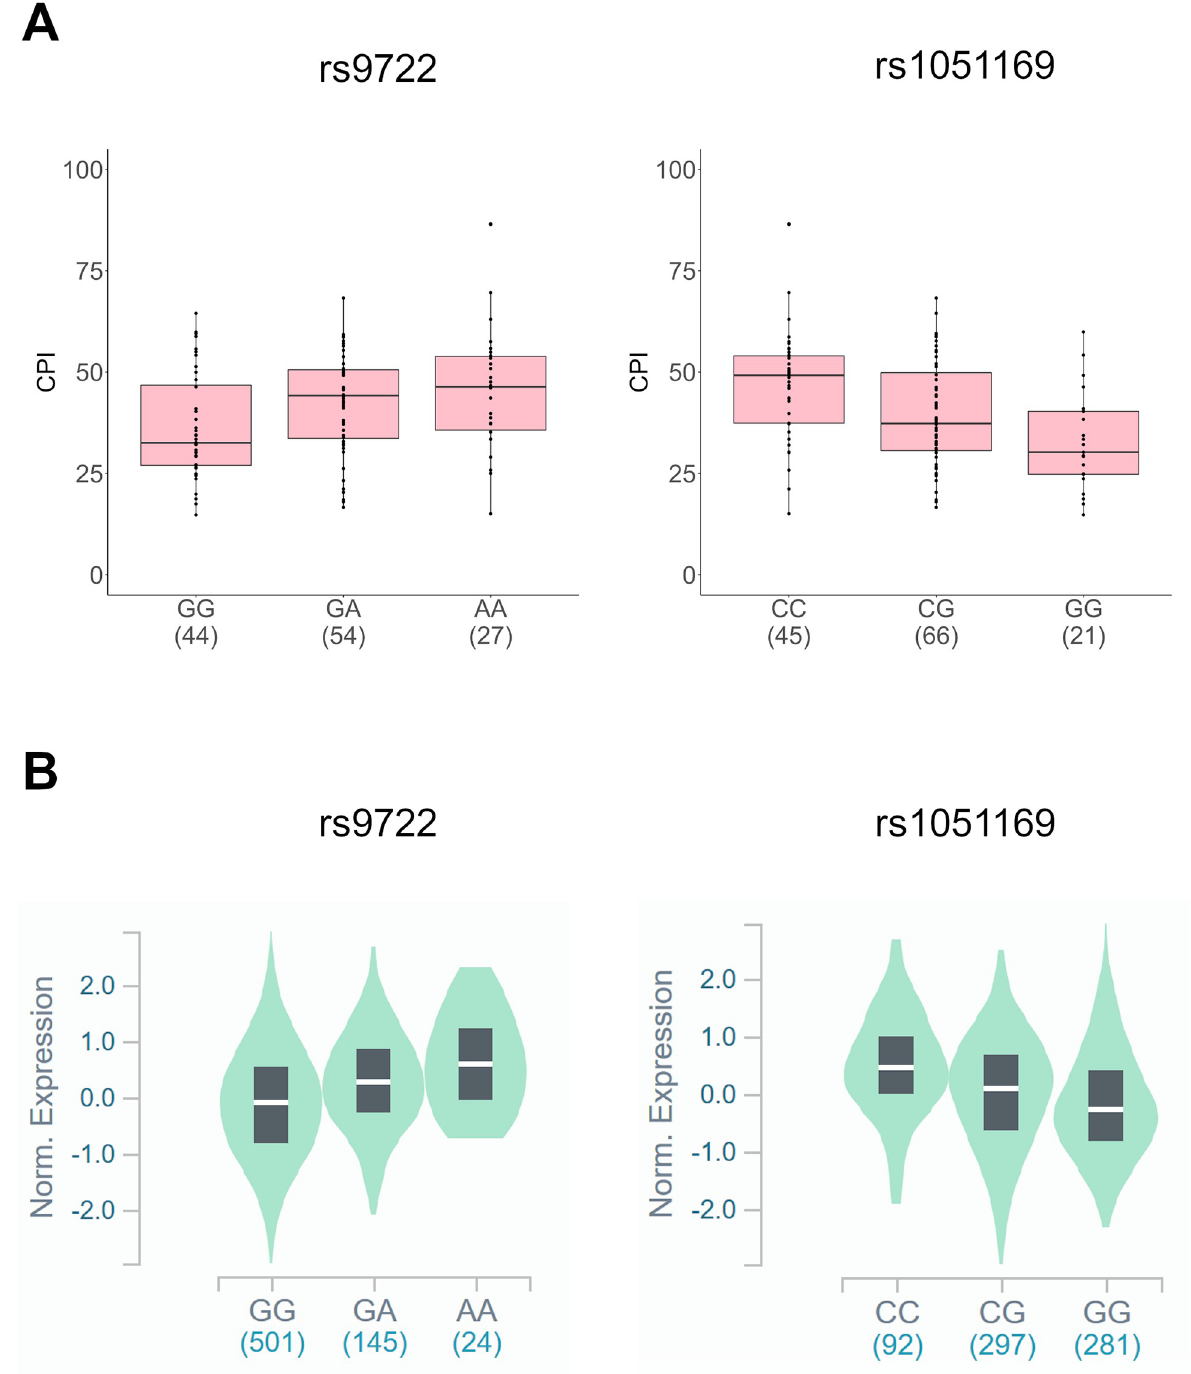
Fig 2. Association of rs9722 and rs1051169 with CPI scores and tissue specific S100B expression. (A) Association of rs9722 and rs1051169 genotypes with CPI scores. (B) Violin plots of single-tissue eQTLs of rs9722 (chr21_46599326_G_A_b38) and rs1051169 (chr21_46602317_C_G_b38) for S100B (ENSG00000160307.9) expression in whole blood from the GTEx Analysis Release V8 (dbGaP Accession phs000424.v8.p2).